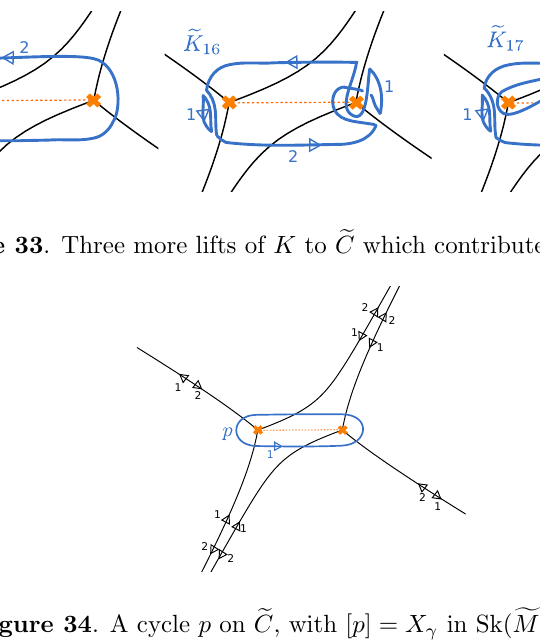
Figure 32 . Two more lifts of K to e C which contribute to F ([ K ]).